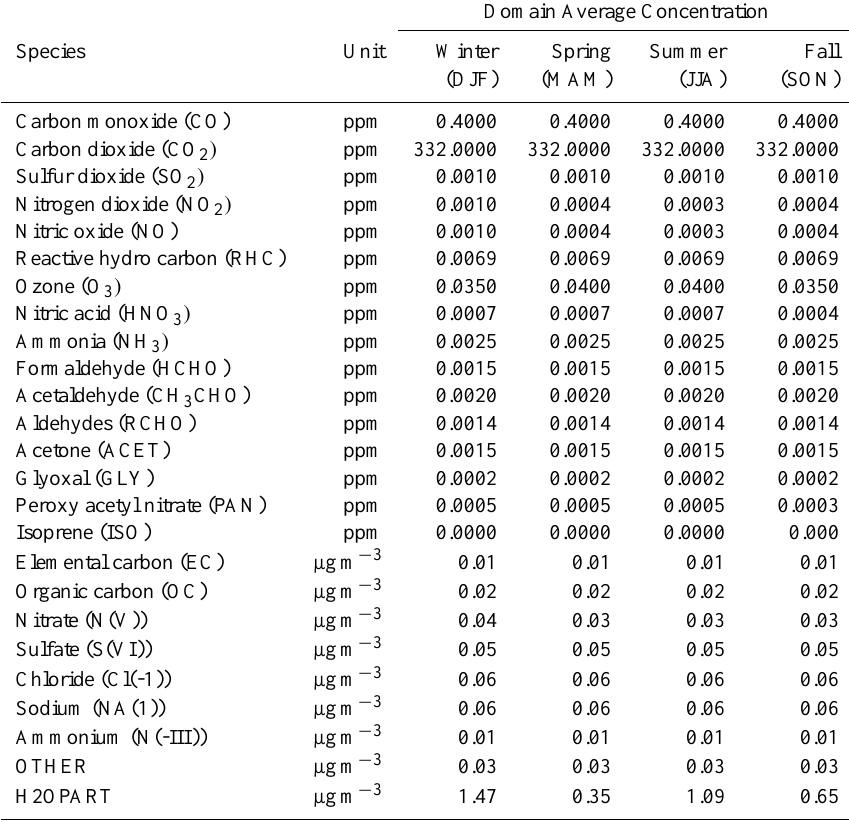
Table 2. Average boundary concentrations of various model gas and particle species concentrations along the western boundary of the modeling